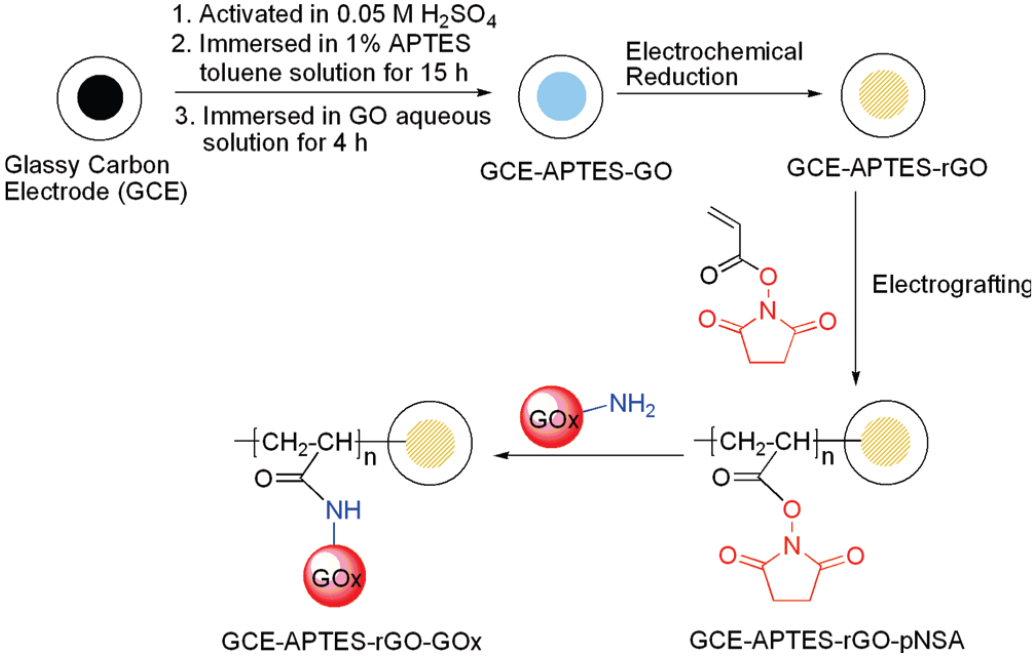
Figure 5. A schematic diagram for electrochemical reduction of GO and the subsequent modification of rGO with GOx [40].